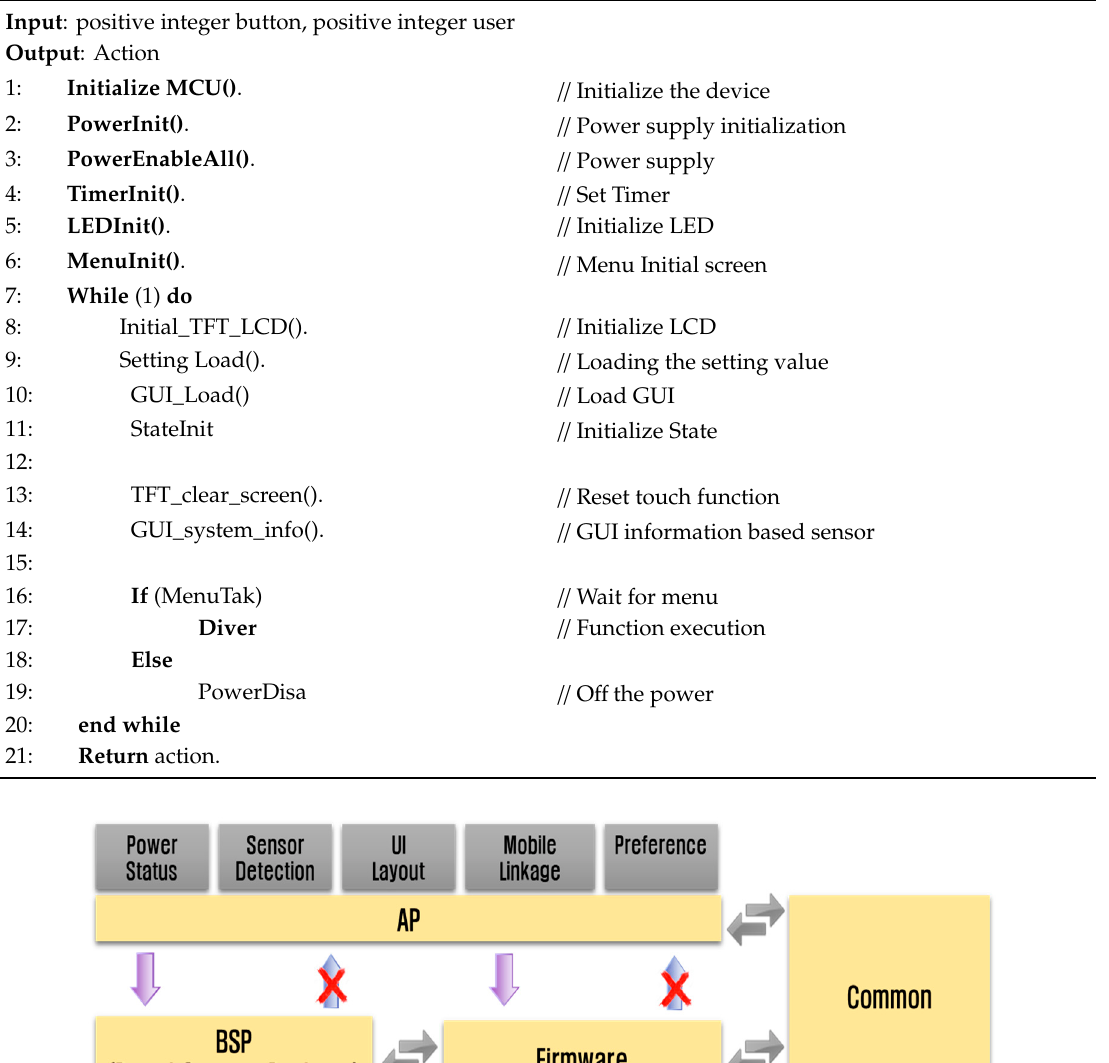
Algorithm 1 DiverPAD firmware logic